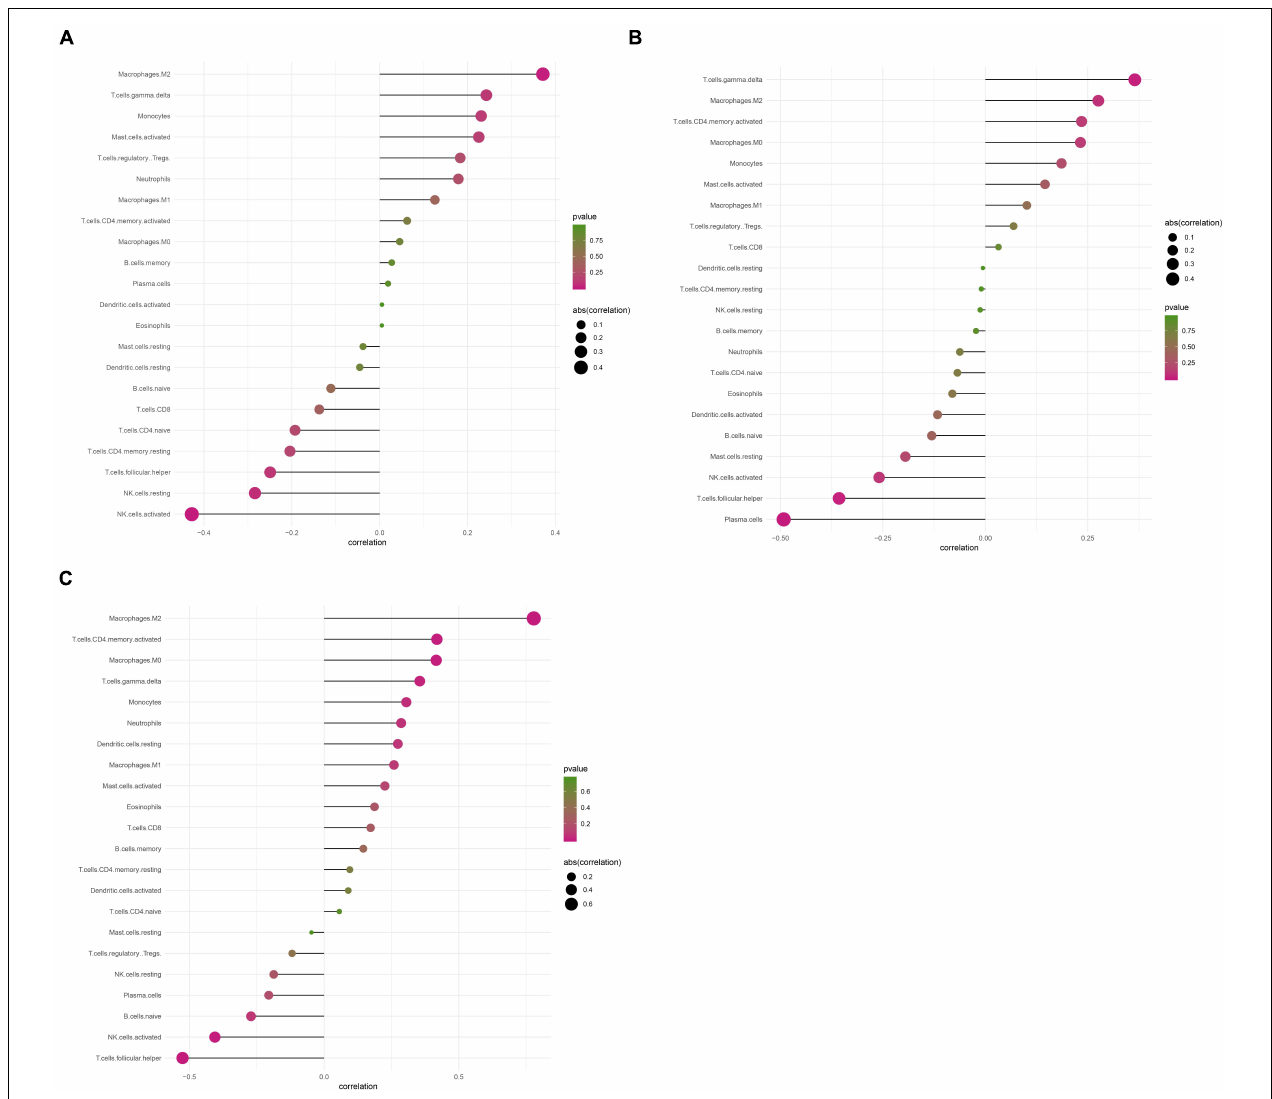
FIGURE 8 | The correlation between levels of immune cell infiltration with expression of three key genes. (A) Correlation between APLNR and 22 immune cells. (B) Correlation between FCGR2A and 22 immune cells. (C) Correlation between CCL21 and 22 immune cells. The size of the dots represents the strength of the correlation between genes and immune cells; with larger dots implying a stronger correlation, and vice versa. The color of the dots represents the p